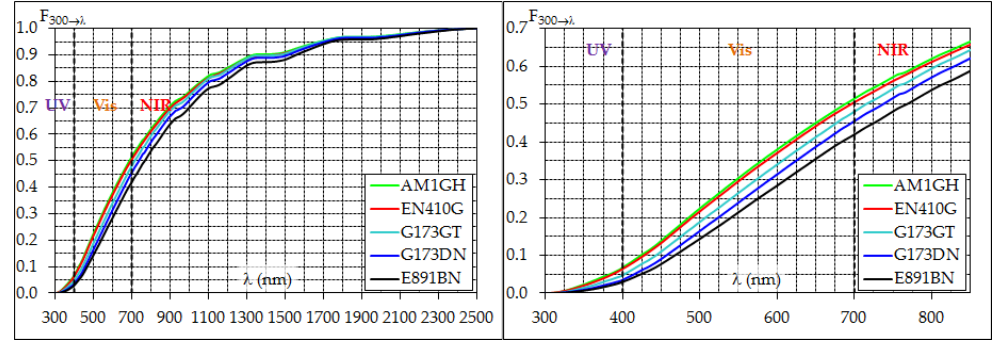
Figure 9. Cumulative energy content vs wavelength (full spectra and close-up on UV-VIS).